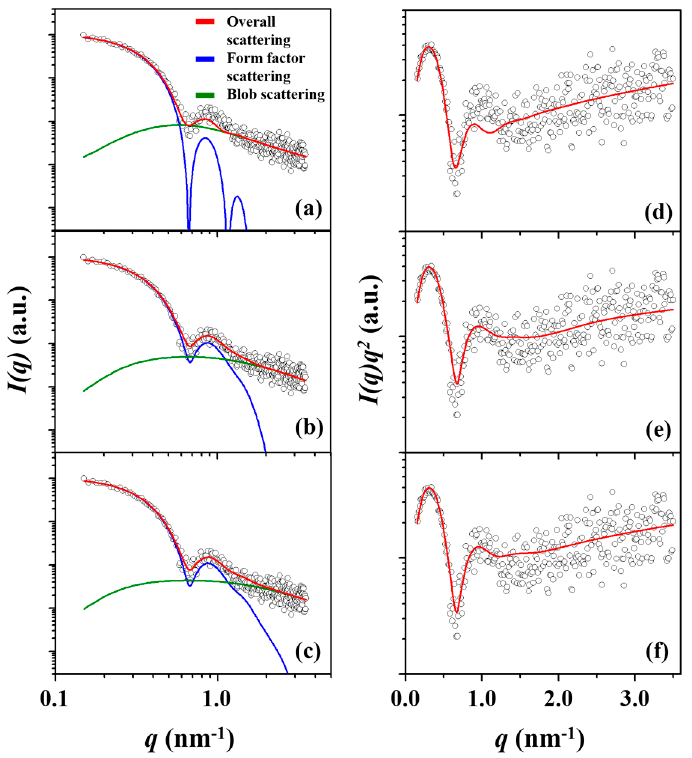
Figure 4. A representative X-ray scattering intensity I ( q ) profile and data analysis results of the l -PBA- b -PEO- b -PBA micelle formed in deionized water with a concentration of 0.5 wt % at 25 ◦ C, which were performed using ( a ) a spherical CFS model, ( b ) a two-phase ellipsoid model, and ( c ) a three-phase ellipsoid model. ( d – f ) Kratky representations of the scattering data of the l -PBA- b -PEO micelle fitted by spherical CFS, two-phase ellipsoid, and three-phase ellipsoid models, respectively. In each figure, the open dot symbols are the measured data and the red solid line represents the sum of the corresponding analysis profile (blue line) and blob contribution (green line). q = (4 π / λ )sin θ in which 2 θ is the scattering angle and λ is the wavelength of the X-ray beam used.